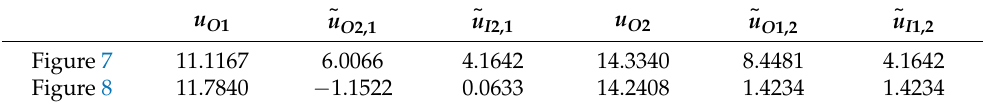
Table 2. Output and input coupling indices of design results shown in Figures 7 and